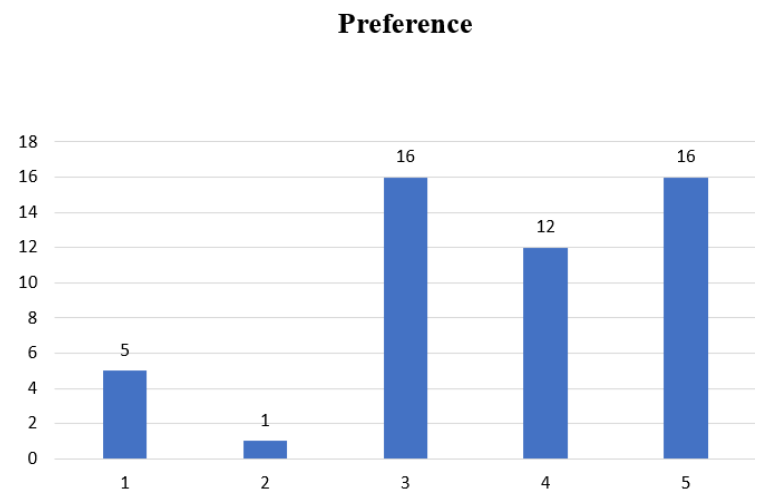
Figure 4. Bar chart showing the levels of preference for Recipes 1–5.